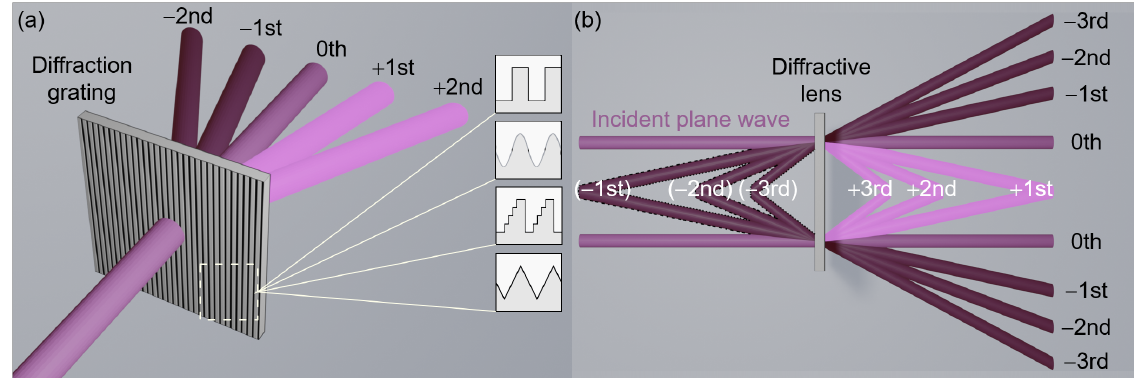
Figure 4. ( a ) The scheme of forming diffraction orders by the grating together with different diffraction grating types— different coding types: binary, sinusoidal, step-like, kinoform. ( b ) The scheme of focusing efficiency of diffractive converging lens. Colors corresponds to particular diffraction grating